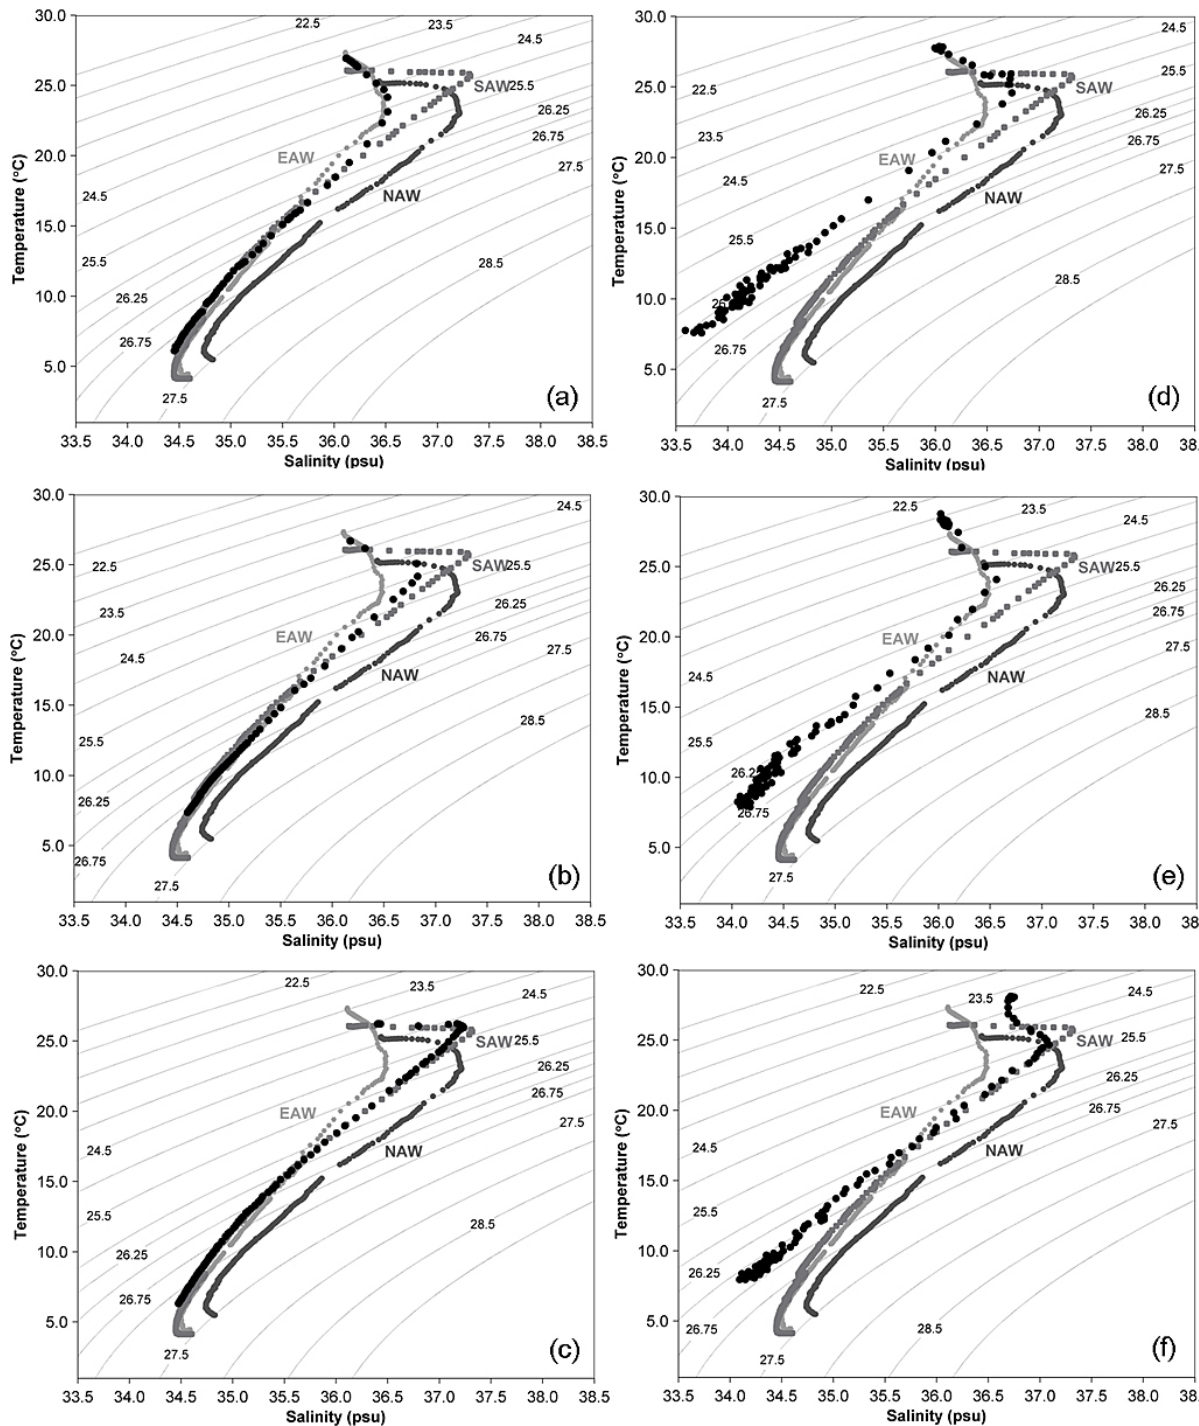
Fig. 2. Typical T/S diagrams for the easternmost REVIZEE stations located between (a, d) 2 ◦ and 4 ◦ S; (b, e) 4 ◦ and 8 ◦ S; (c, f) 8 ◦ and 14 ◦ S. The first column (a, b, c) refers to the winter and the second one (d, e, f) to the summer. Each diagram has a representative station shown as black full